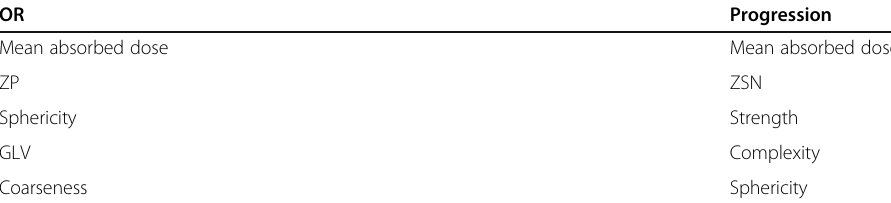
Table 2 Top 5 features for the combined models with robust radiomics features, volume, and absorbed dose OR